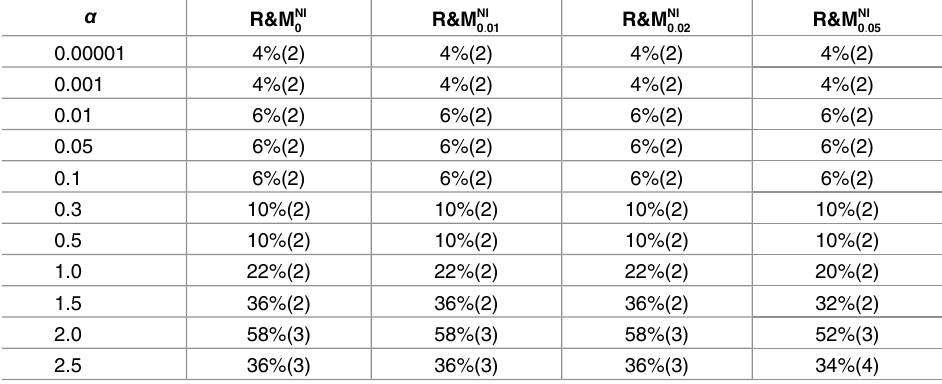
Table 5. The results of Scenario B3. Percentage of data sets in which the true numberof clusters was found, with the mode of the estimated number of classes in parentheses. α R&M NI 0